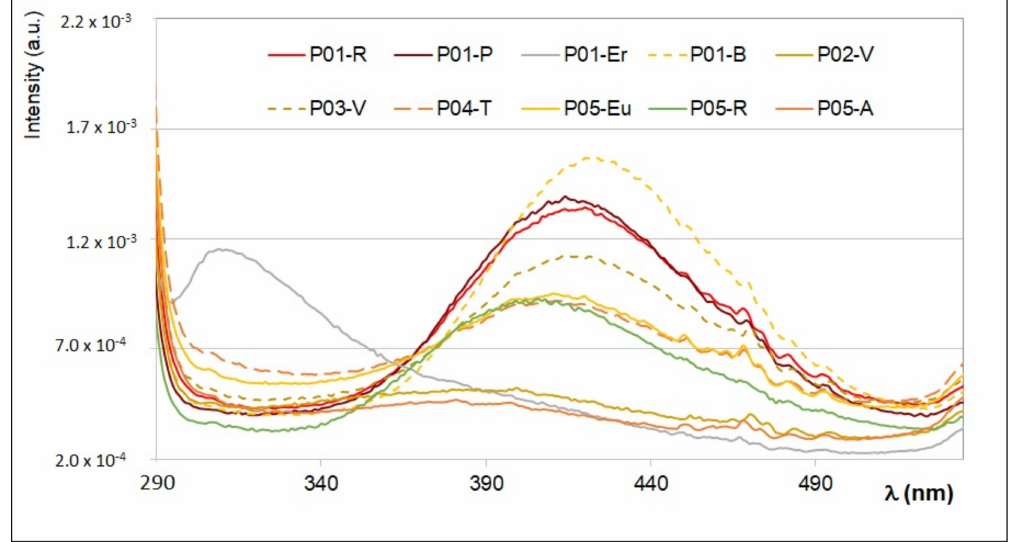
Figure 3. Superposition of the FFF emission spectra of the ethanol extracts of the ten bee pollen samples, prepared as described in the main text, obtained by exciting the sample at λ ex = 280 nm. The intensity was